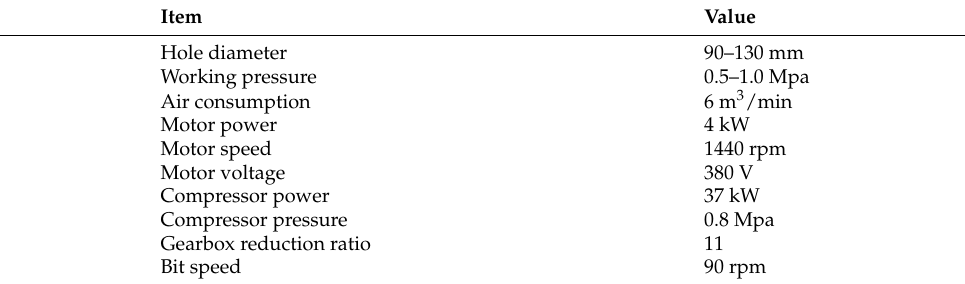
Table 1. DTH Drilling system